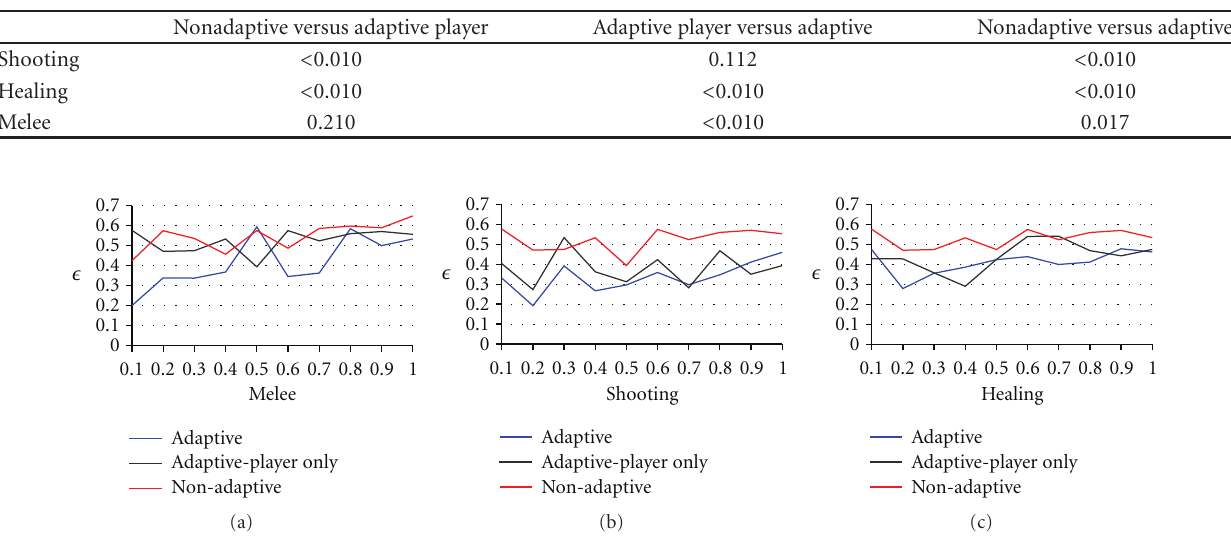
Figure 7: Versatility test results for the fundamental TAP experiments: plot of E against the melee, shooting, and healing probability, respectively. The color code is the same as in Figure 7.